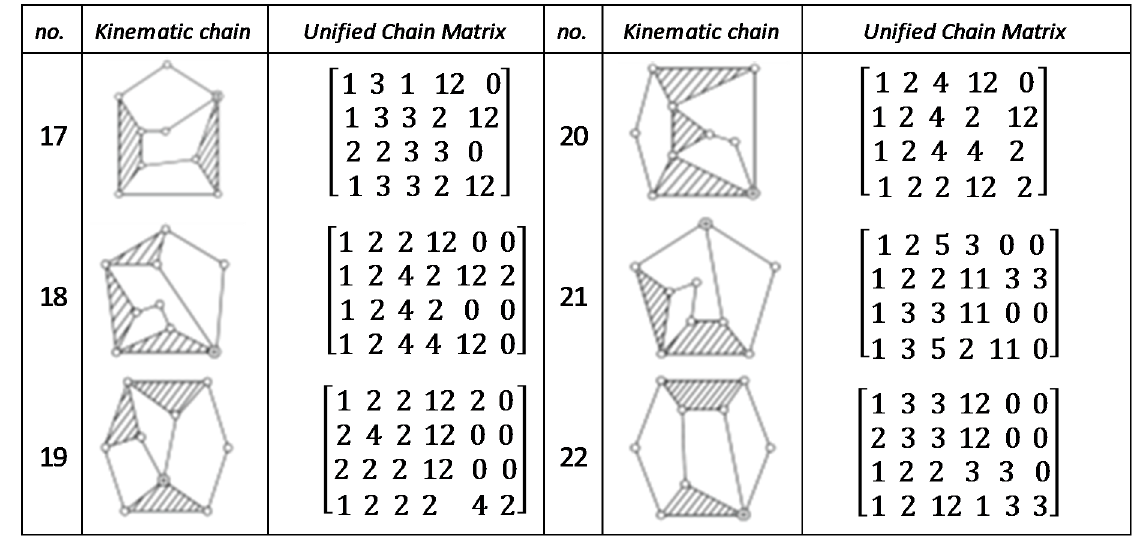
Figure A2. Unified chain matrix, UCM, for all 8 links 1-DOF KCs with 1 multiple joint [25].